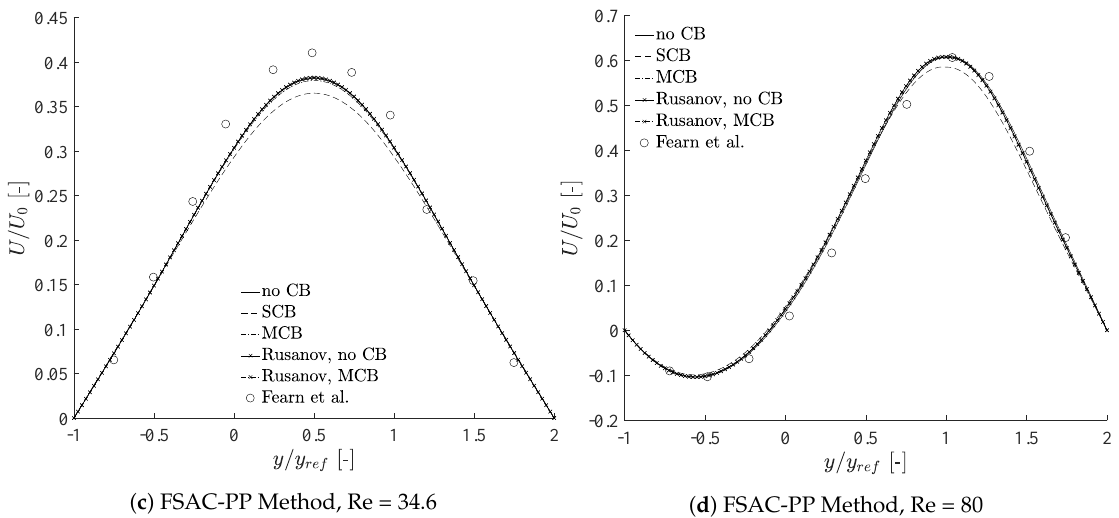
Figure 4. Velocity profiles at x / S = 5 for the AC ( top ) and FSAC-PP ( bottom ) method using different combinations of CB schemes and the Rusanov Riemann solver at Re = 34.6 ( left ) and Re = 80 ( right